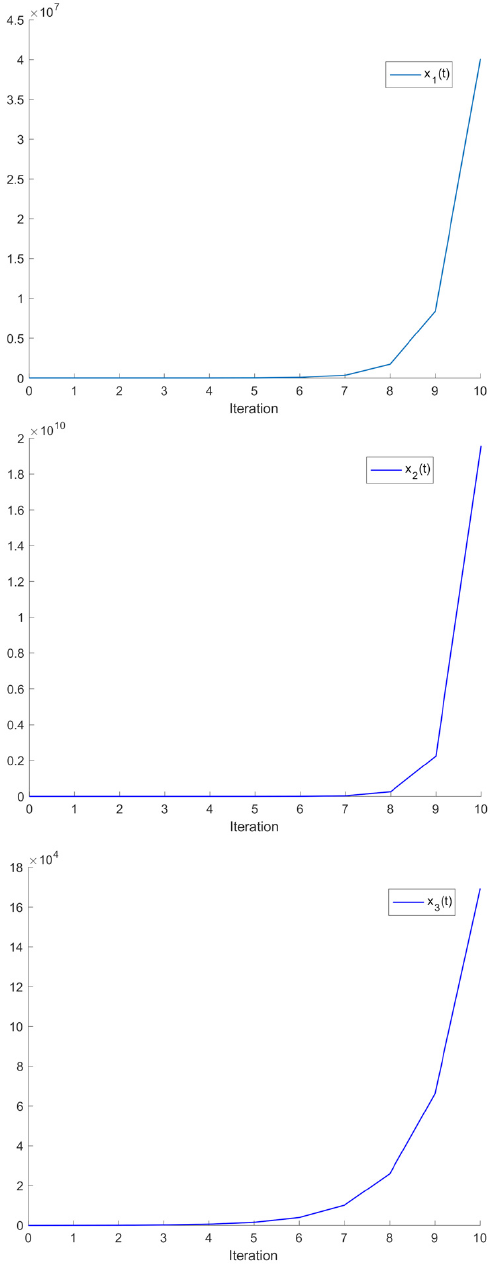
Figure 9. Evolution of the stock vector x t for the uncontrolled case in Example